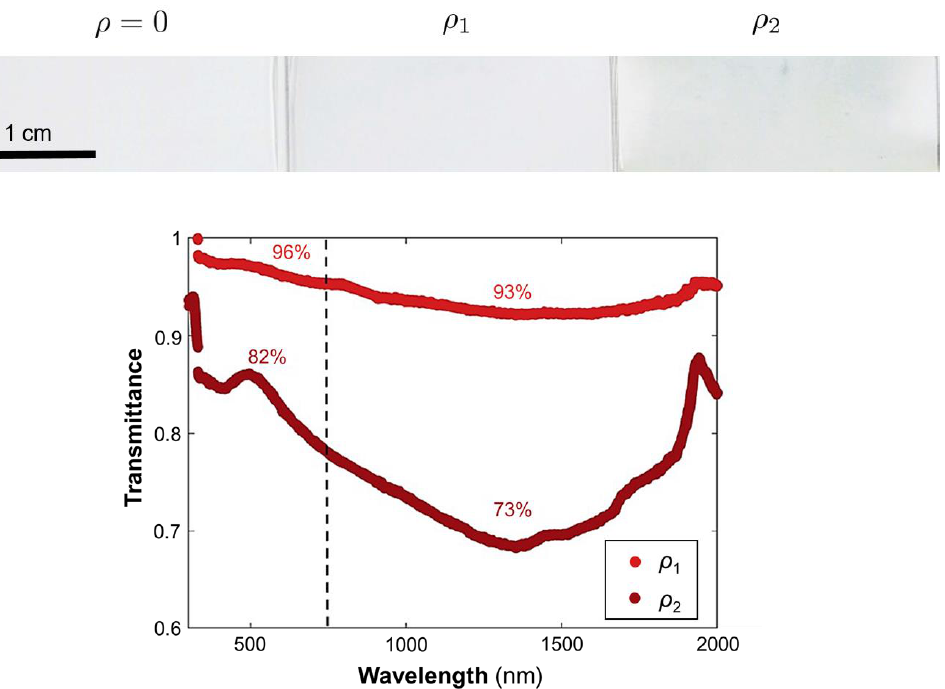
Figure 6. Photographs of the prepared films on glass with increasing Ag-nanoshell concentrations (left to right). Transmittance spectra of the doped films in the solar range. The spectra were normalized relative to undoped spectrum ( ρ 0 ). The labeled percentages represent the average transmittance in the visible (<750 nm) or the NIR (>750 nm).